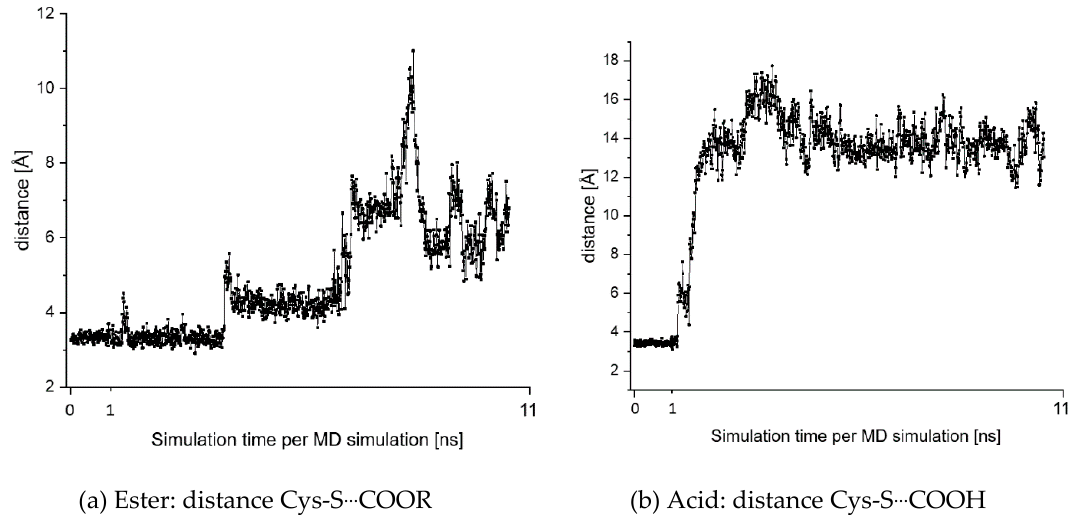
Figure 8. Fluctuations in the distance between the sulfur center of Cys-25 and ( a ) the carbon center of the ester group of compound 7 and ( b ) the carbon center of the acid group. The simulations were started from the pose given in Figure 7.